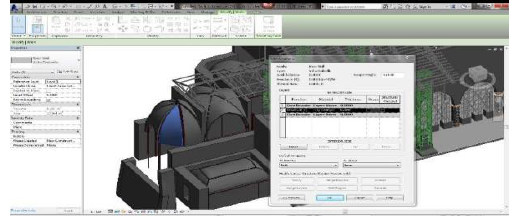
Figure 2.3D ©Revit model of the Basilica St. Maria and